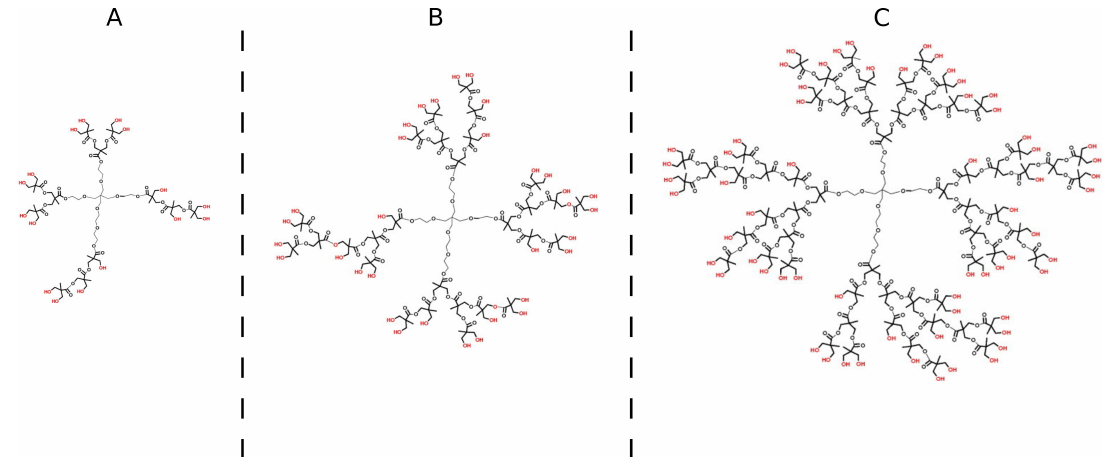
Figure 1. The molecular structures of hyper-branched bis-MPA polyester-16-hydroxyl polymer, generation 2 ( A ), hyper- branched bis-MPA polyester-32-hydroxyl polymer, generation 3 ( B ), and hyper-branched bis-MPA polyester-64-hydroxyl polymer, generation 4 ( C ).